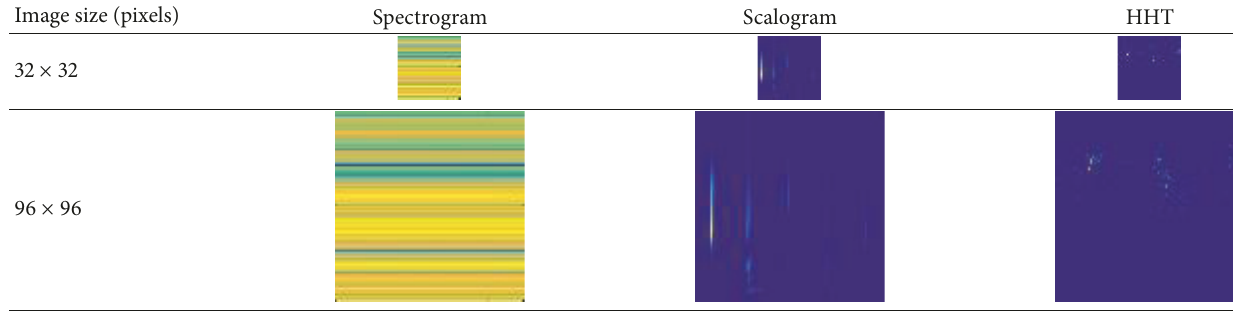
Table 4: MFPT inner race images.